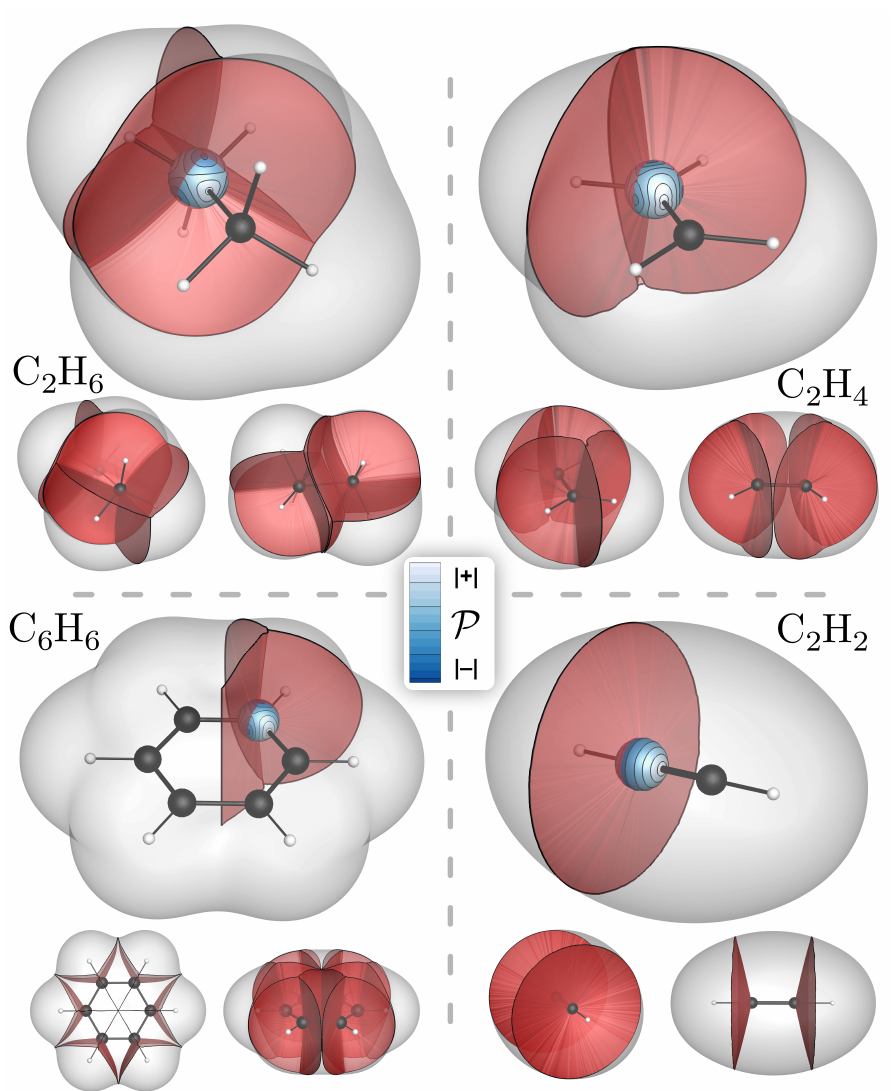
Figure 3. C atom bond wedges shown intersecting reference spheres with mapped contours of P in ethane, benzene, ethylene, and acetylene (bond orders of 1, 1.5, 2, and 3). For each molecule, the full set of inter-bond surfaces is shown. Surfaces are truncated at the ρ = 0.001